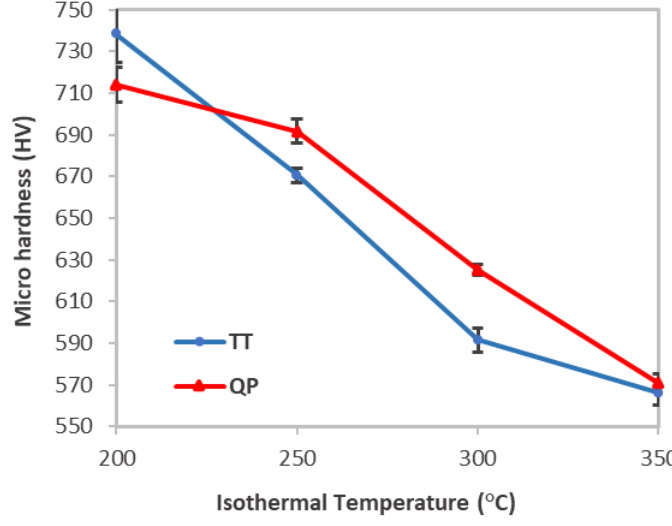
Figure 4. Hardness measurement at different tempering temperatures. Table 2. RA phase fraction of TT and QP